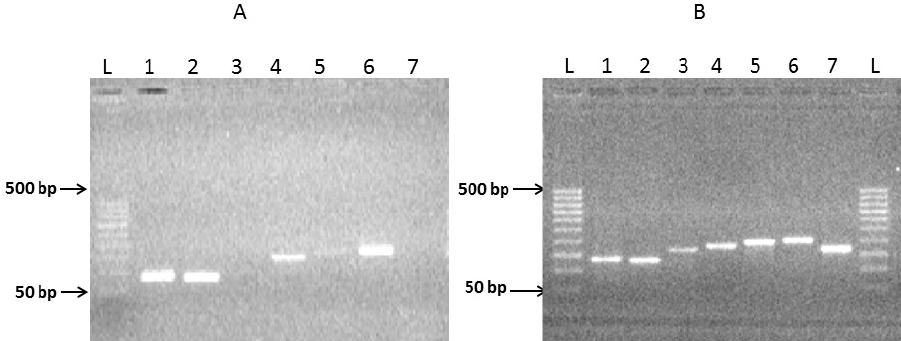
Figure 2. Amplification of individual exons of hRenalase1. ( A ) Agarose gel electrophoresis of PCR products of hRenalase1 exons obtained using the human genomic DNA; ( B ) Step 1 of PCR amplification of hRenalase1 exons using human genomic DNA as a template. The calculated sizes of the amplified exons (corrected for the presence of the OS sequences) were: 1—1ExRe1 (131 bp); 2—2ExRe1 (126 bp); 3—3ExRe1 (166 bp); 4—4ExRe1 (179 bp); 5—5ExRe1 (193 bp); 6—6ExRe1 (197 bp); 7—7ExRe1 (188